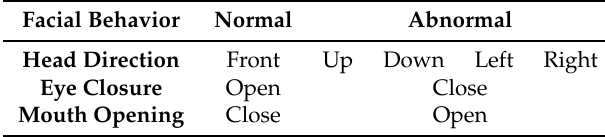
Table 3. The tasks of the facial behavior